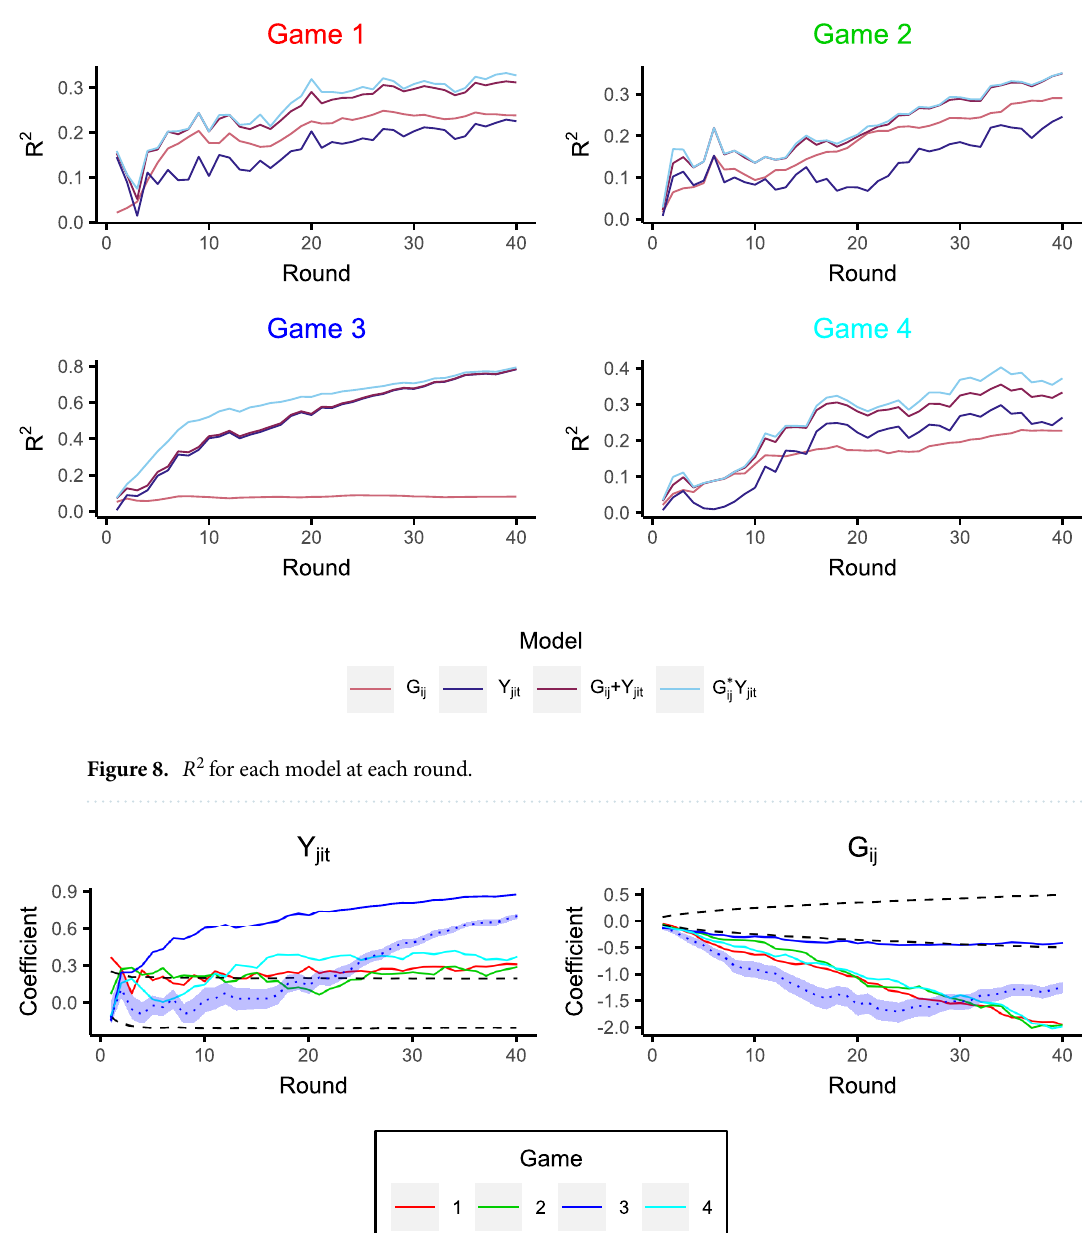
Figure 9. Coefficients for the additive effects models at each round. Solid coloured lines are the game coefficients. Black dashed lines are the 95% bands from the synthetic giving-at-random null games. The dotted line is the average coefficient from semi-synthetic data based on game 3 (explained in the “Game 3” section), and the surrounding shaded region displays the 95%